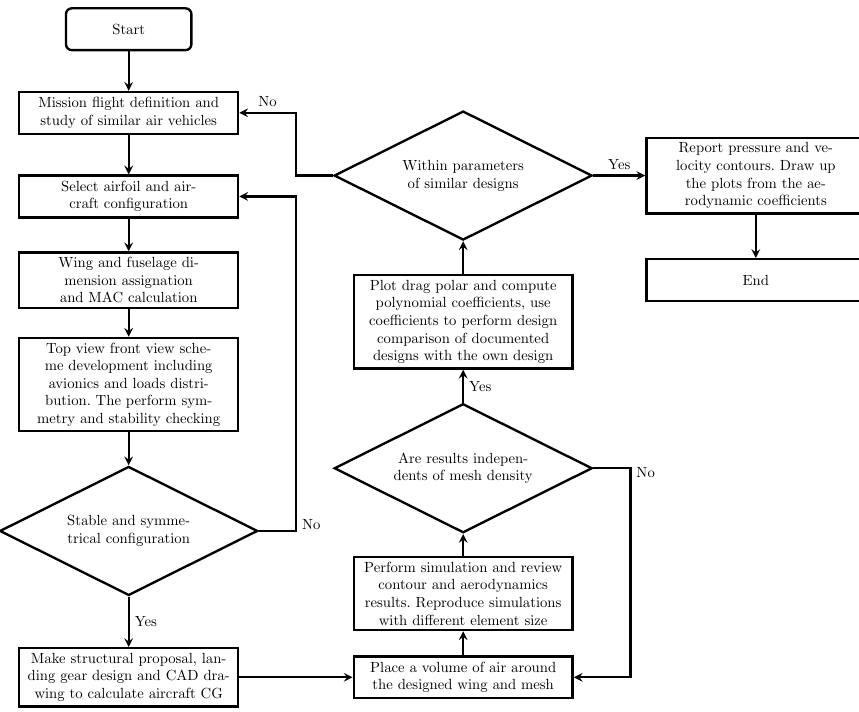
Figure 1. Flow chart of the wing design